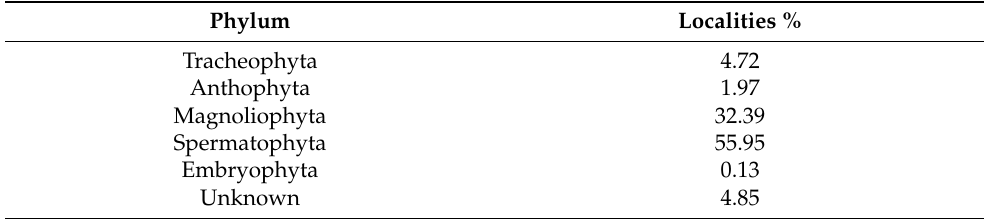
Table 3. Relative abundance at the phylum level of plant communities from different localities.